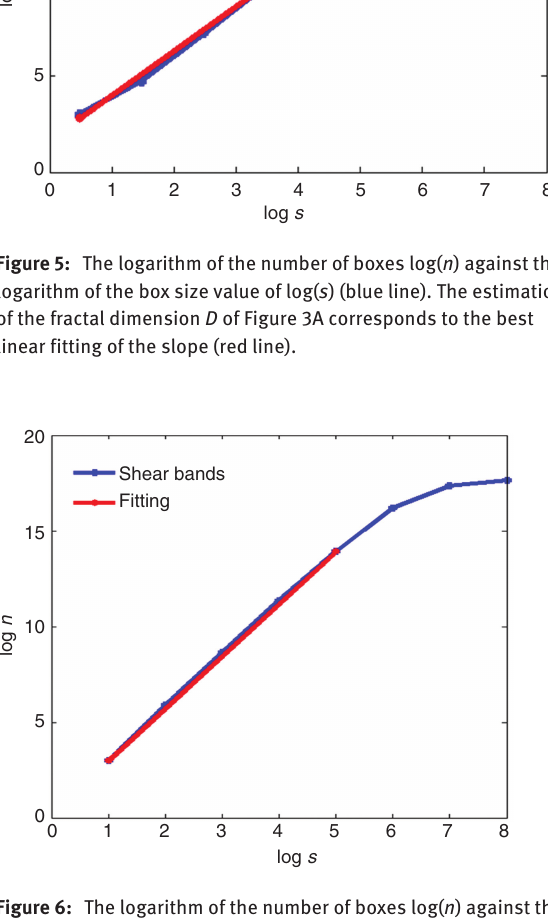
Figure 6: The logarithm of the number of boxes log( n ) against the logarithm of the box size value of log( s ) (blue line). The estimation of the fractal dimension D of Figure 4B corresponds to the best linear fitting of the slope (red